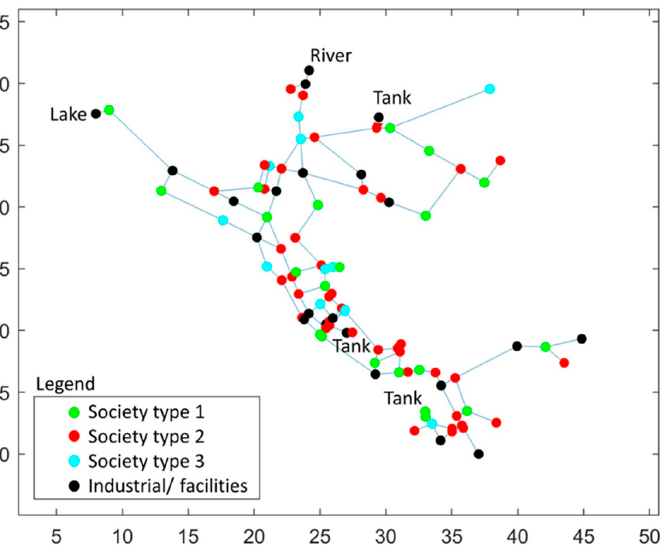
Figure 2. Distribution of three society types, including industrial and facility nodes in the EPANET example application network, Net3.